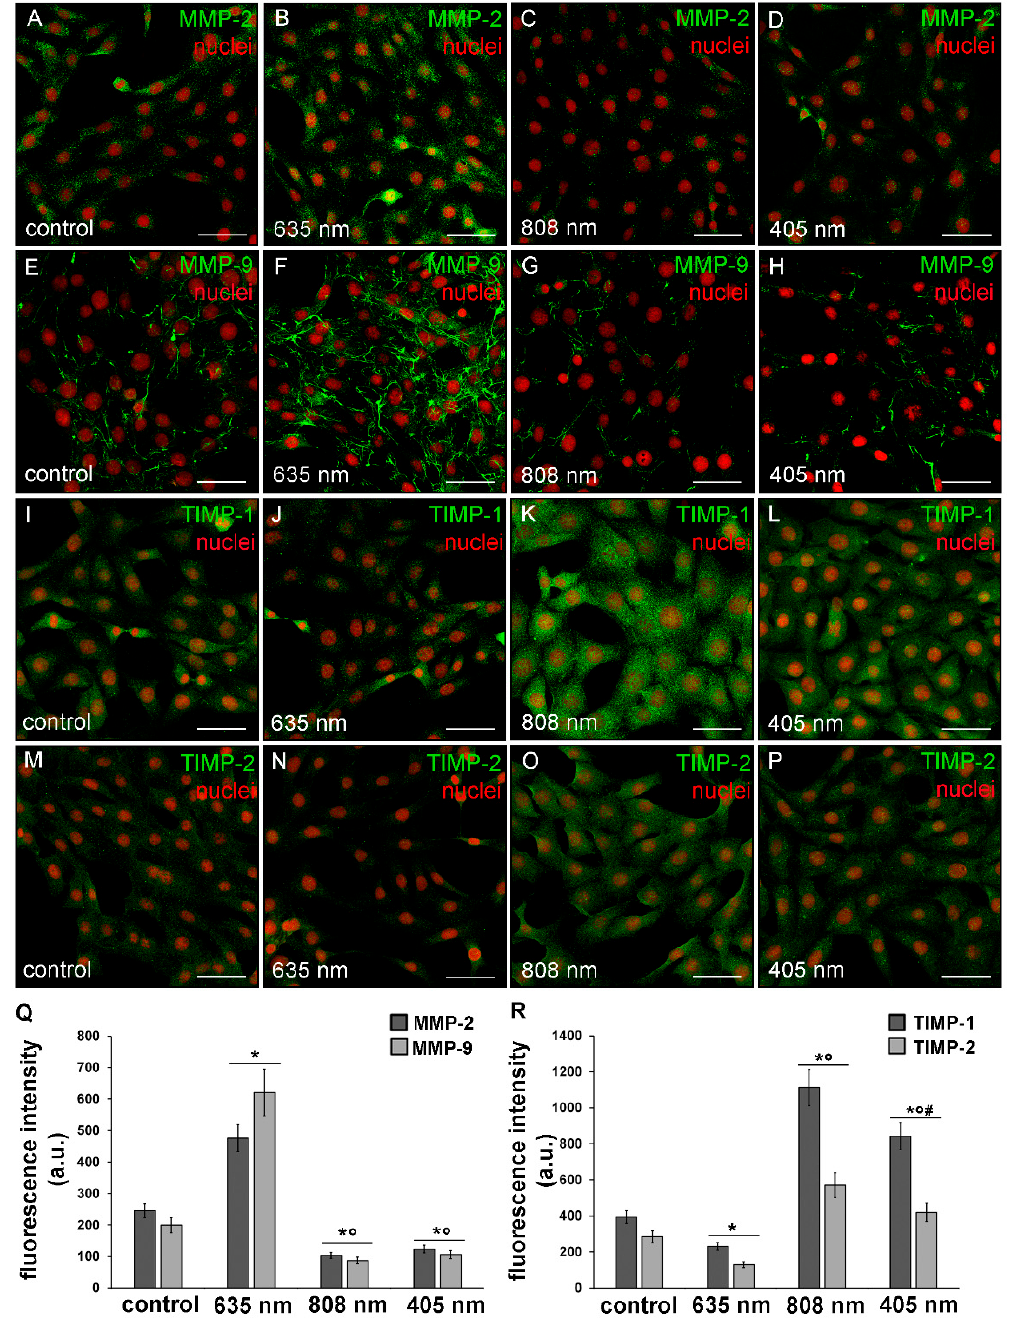
Figure 9. Confocal immunofluorescence analysis of the expression of MMP-2 and MMP-9 and of their inhibitors, TIMP-1 and TIMP-2, in NIH / 3T3 fibroblasts 24 h after cell exposure to red (635 nm), NIR (808 nm) and violet-blue (405 nm) PBM. Cells not subjected to PBM treatments served as control. ( A–P ) Representative confocal fluorescence micrographs of fixed cells immunostained for detection of ( A–D ) MMP-2, ( E–H ) MMP-9, ( I–L ) TIMP-1 and ( M–P ) TIMP-2 (green). Nuclei are labeled in red with PI. Scale bar: 50 µ m. ( Q , R ) Histograms showing the densitometric analysis of ( Q ) MMP-2 and MMP-9 and of ( R ) TIMP-1 and TIMP-2 fluorescence intensity performed on digitized images. Significance of difference in Q: * p < 0.01 vs. relative control; ○ p < 0.01 vs. 635 nm; p = 0.067 MMP-2, 405 nm vs. 808 (cid:35) nm; p = 0.06, MMP-9 405 nm vs. 808 nm. Significance of difference in R: * p < 0.01 vs. relative control; ○ p < 0.01 vs. relative 635 nm, # p < 0.01 vs. relative 808 nm.